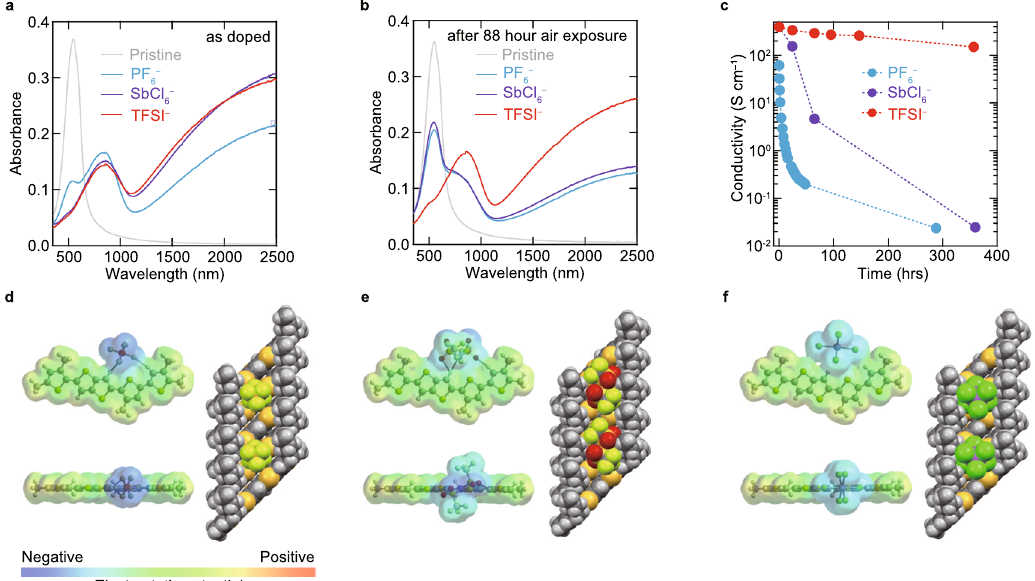
Fig. 5 Ambient stability of doped PBTTT. UV-Vis-NIR spectra for a pristine (gray), TBPA-PF 6 (light blue), TBPA-SbCl 6 (purple), and TBPA-TFSI (red) doped PBTTT thin fi lms. Data were acquired ( a ) as doped and ( b ) after 88 h air exposure. c Ambient stability of conductivities of TBPA-PF 6 (light blue), TBPA-SbCl 6 (purple), and TBPA-TFSI (red) doped PBTTT thin fi lms. Electrostatic potential map on molecular surfaces for ion pairs of ( d ). PBTTT/PF 6 , ( e ) PBTTT/SbCl 6 , and ( f ) PBTTT/TFSI, together with their space- fi lling, van der Waals-based representation. The calculations of these potentials